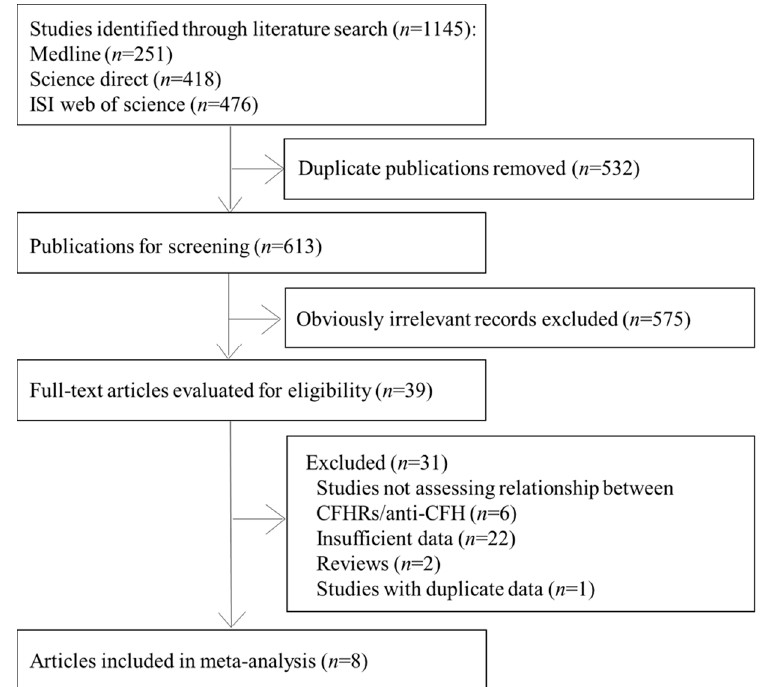
Figure 1. Flowchart for the selection of eligible studies.